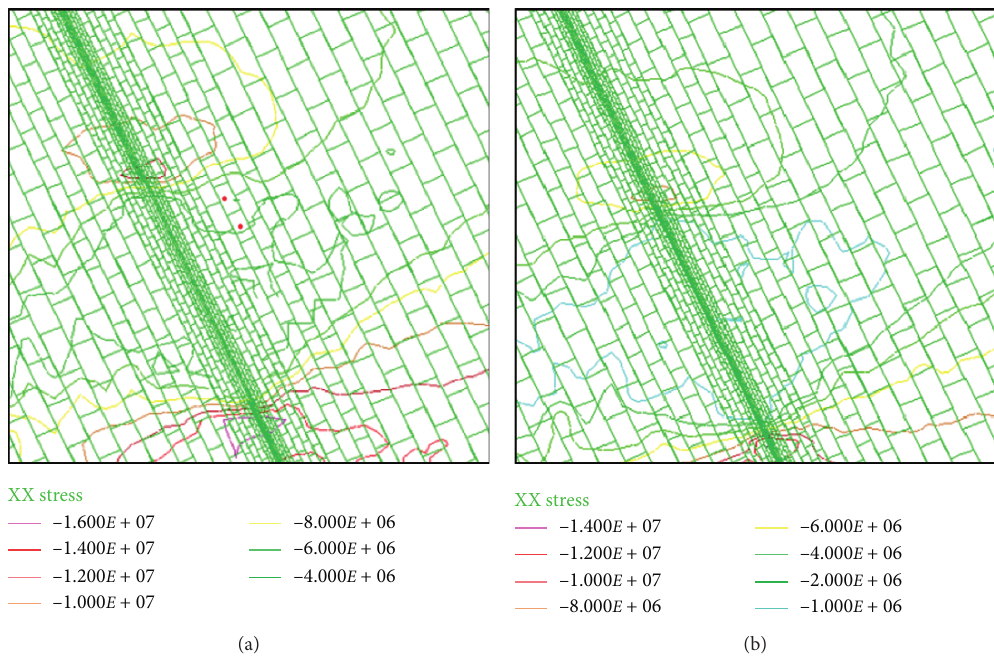
Figure 12: Surrounding rock horizontal stress distribution with 160m stope height. (a) Caving. (b)